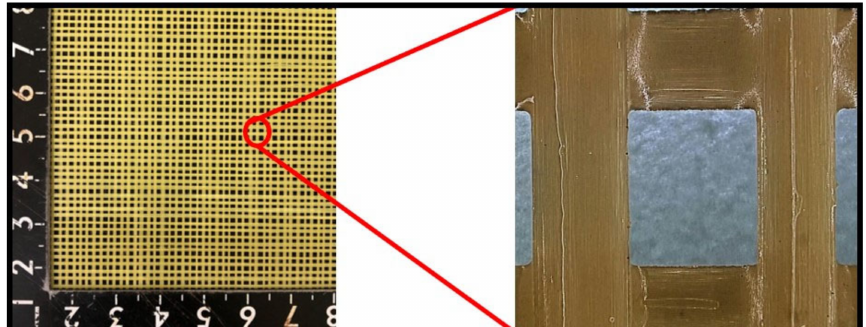
Figure 2. Photographs of the composite sample and the partial amplification.